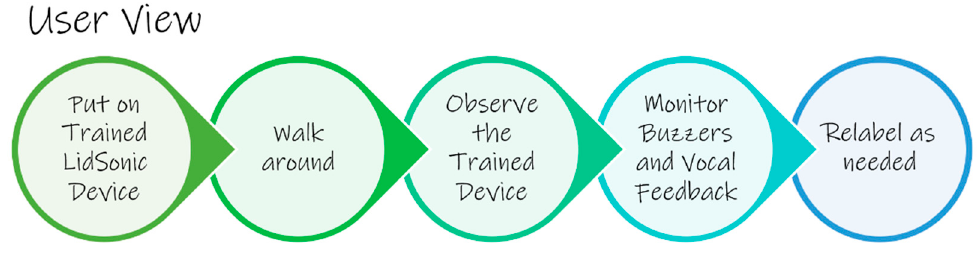
Figure 2. The steps a user takes to setup and use